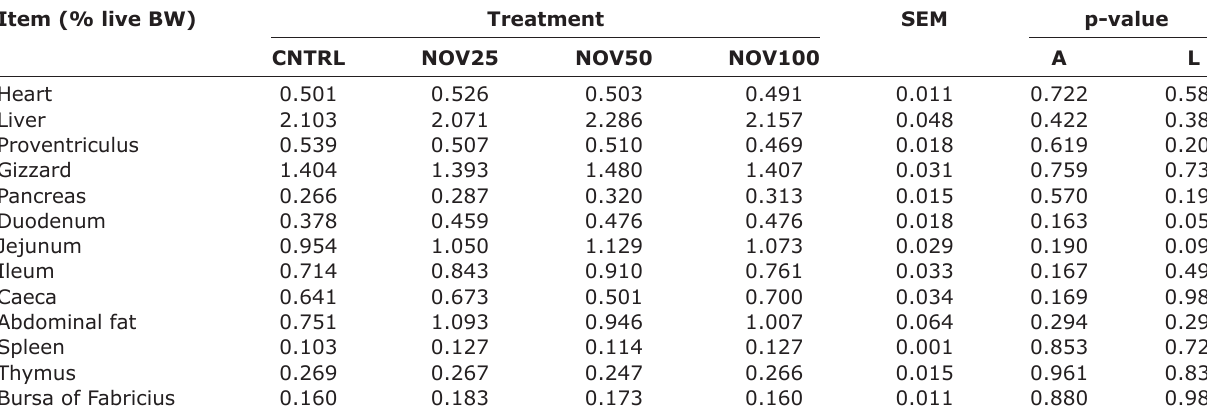
Table-3: Relative weight of internal organ of broilers.